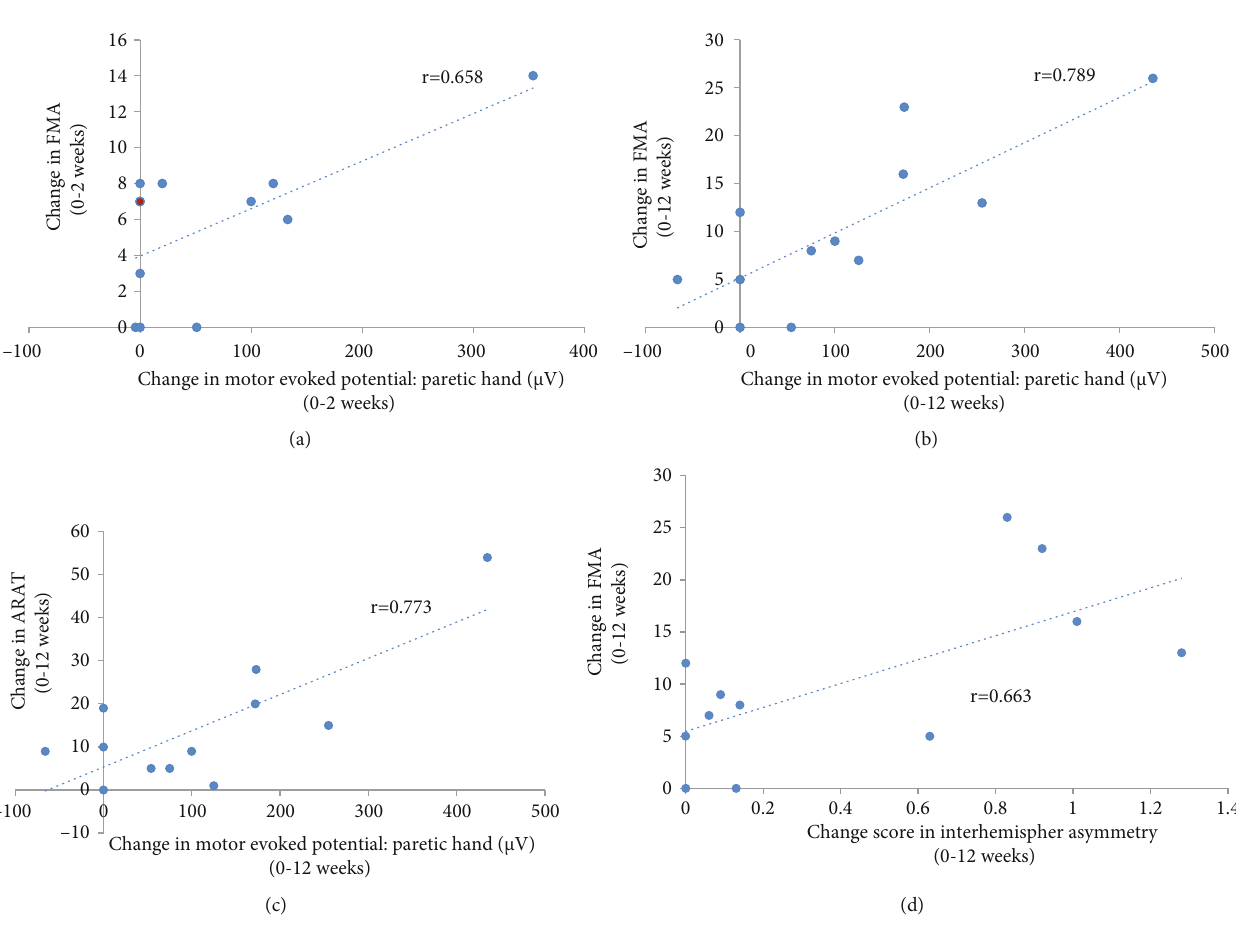
Figure 3: Association of changes in MEP amplitude and interhemispheric asymmetry with functional outcomes ( n = 12 ). In the experimental group, the change in MEP amplitude over the 2-week stimulation period was signi fi cantly correlated with change in FMA ( r = 0 : 658 , p = 0 : 020 ) (a). Two participants who had the same combination of FMA and paretic hand MEP (a) values are indicated by the red dot. The change in MEP on the paretic side was correlated with that in FMA ( r = 0 : 789 , p = 0 : 002 ) (b) and ARAT scores (0.773, p = 0 : 003 ) (c) over the 12-week study period. The change of interhemispheric asymmetry was also correlated with that in FMA ( r = 0 : 663 , p = 0 : 019 ) over the 12-week study period